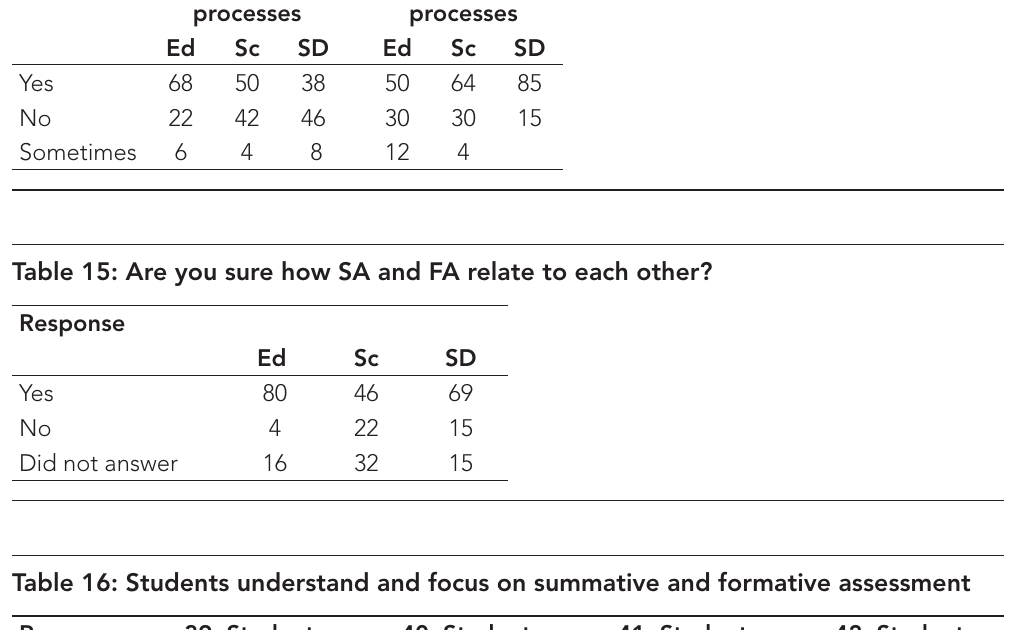
Table 14: Summative and formative assessment are different or similar processes Response